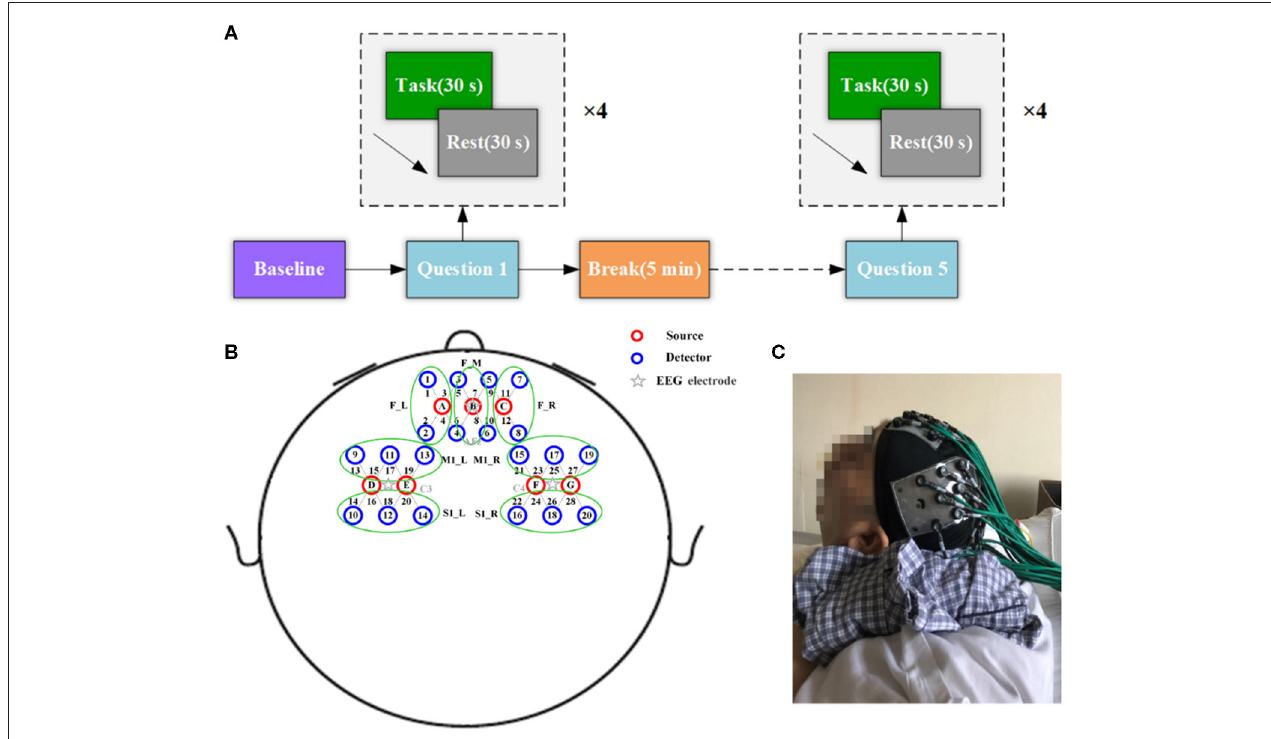
FIGURE 2 | Experimental configuration. (A) Experimental paradigm of motor imagery tasks. (B) Arrangement of probes on the head. Specifically, seven sources (red circles) and 20 detectors (blue circles), yielding 28 optical channels (gray lines marked with channel numbers). (C) Photograph of the experimental